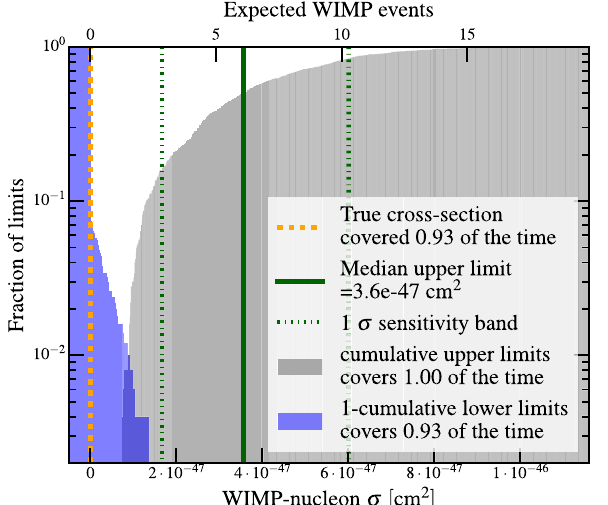
Fig. 4 Expected distribution of upper and lower limits for XENON1T, for a 50 GeV / c 2 spin-independent WIMP search, with the true cross- section at 0 (orange dashed line) from Ref. [21]. The fraction of upper limits excluding a certain cross-section represented by the x-axis are shown in gray; in other words, for an ensemble of trials with zero signal, what fraction of derived upper limits will exclude a given cross-section as a function of cross-section. The blue region shows the corresponding fraction for lower limits. The upper x-axis shows the signal expectation corresponding to the cross section on the lower x-axis in number of events – the upper limit tail reaches down to only two events. The dash- dotted green lines show the central 68% of upper limits. The median upper limit is about a factor of ∼ 2 different from the 1 σ lines